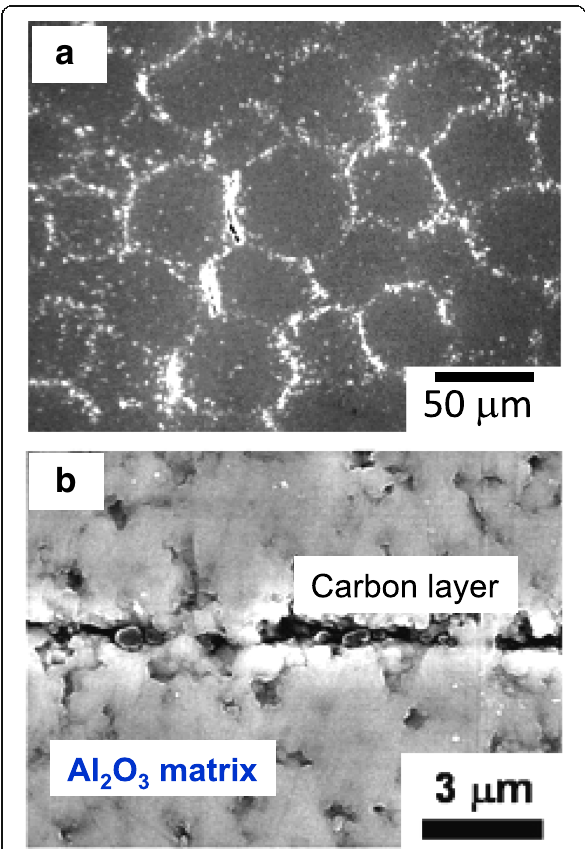
Fig. 4 a Microstructure of 0.6 vol% CNP-Al 2 O 3 composite using Al 2 O 3 with the average diameter of 62 μ m. b Grain boundary of CNP-Al 2 O 3 composite. Carbon layer could be observed at the interface between the Al 2 O 3 matrix